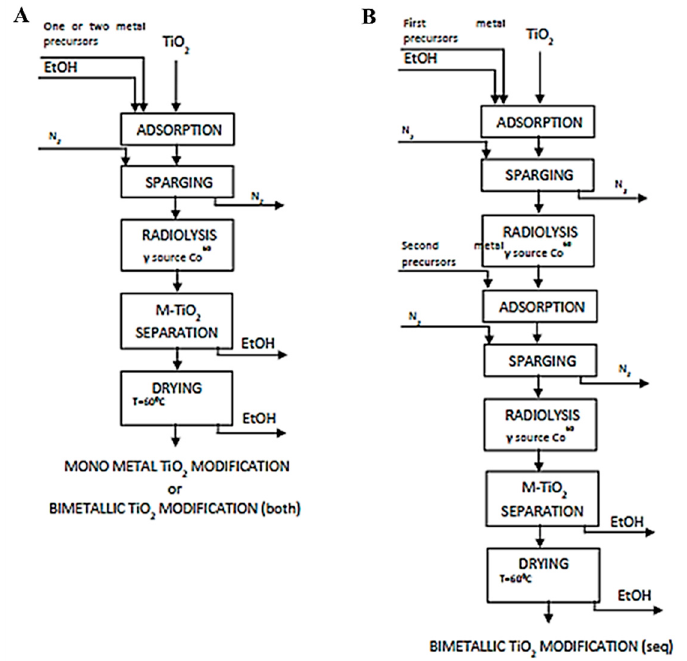
Figure 6. Block diagram of ( A ) mono metal or bimetallic (both) TiO 2 modification and ( B ) bimetallic TiO 2 modification (seq) [264].